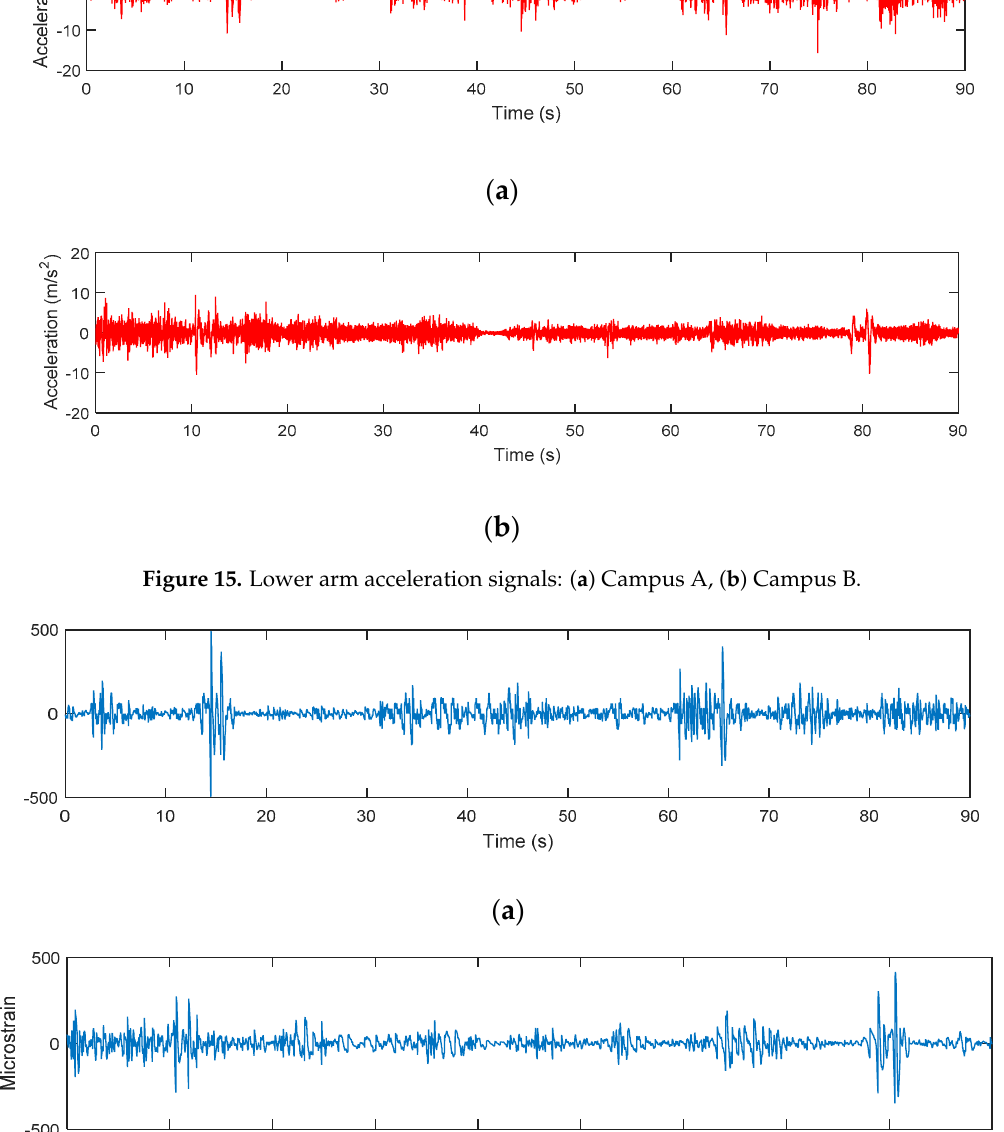
Figure 16. Elastic-energy strain signals: ( a ) Campus A, ( b ) Campus B.